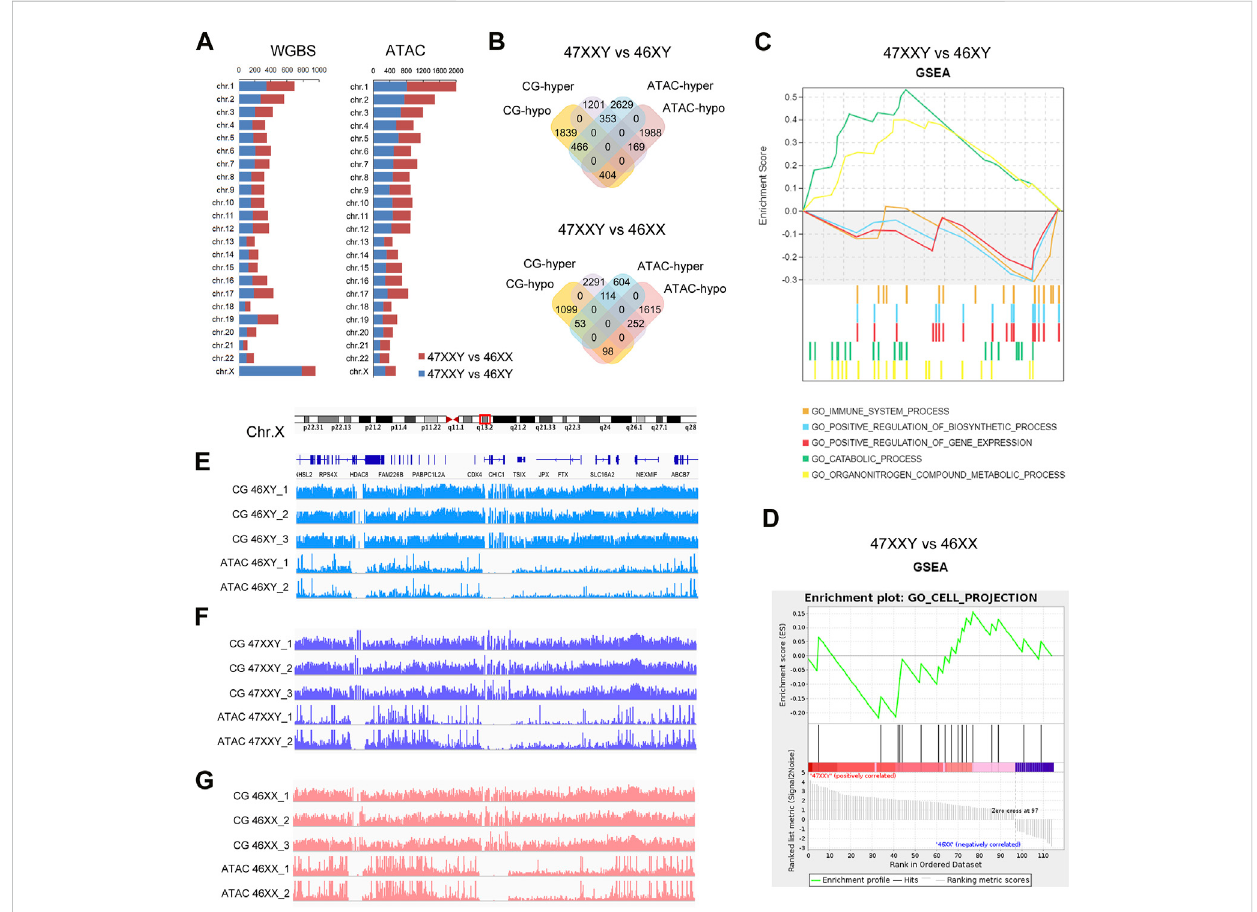
FIGURE 4 The combination result of WGBS and ATAC-seq (A) Chromosome location number in 47XXY vs. 46XY, 47XXY vs. 46XX of WGBS and ATAC-seq (B) Venn diagrams of hyper and hypo CG DMR anchoring genes and ATAC-seq in 47XXY vs. 46XY, 47XXY vs. 46XX. (C) GSEA analysis in combination data of two series (WGBS and ATAC-seq) in 47XXY vs. 46XY. (D) GSEA analysis in combination data of two series (WGBS and ATAC-seq) in 47XXY vs. 46XX. (E – G) IGV map of Chr.X q13.2 in two series data (WGBS and ATAC-seq) from 46XY, 47XXY and 46XX